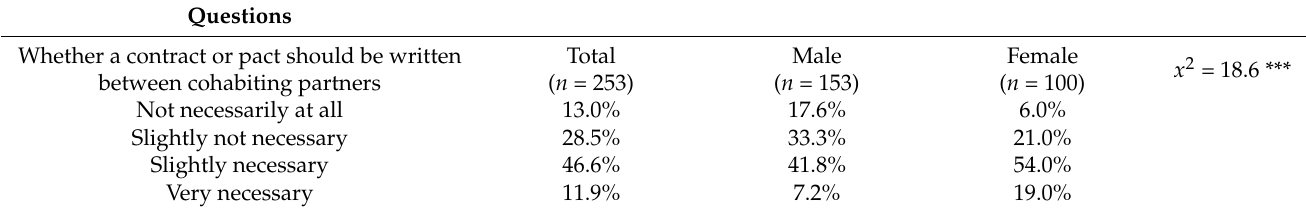
Table 5. ANOVA on cohabitants’ need for a contract by sex ( n =